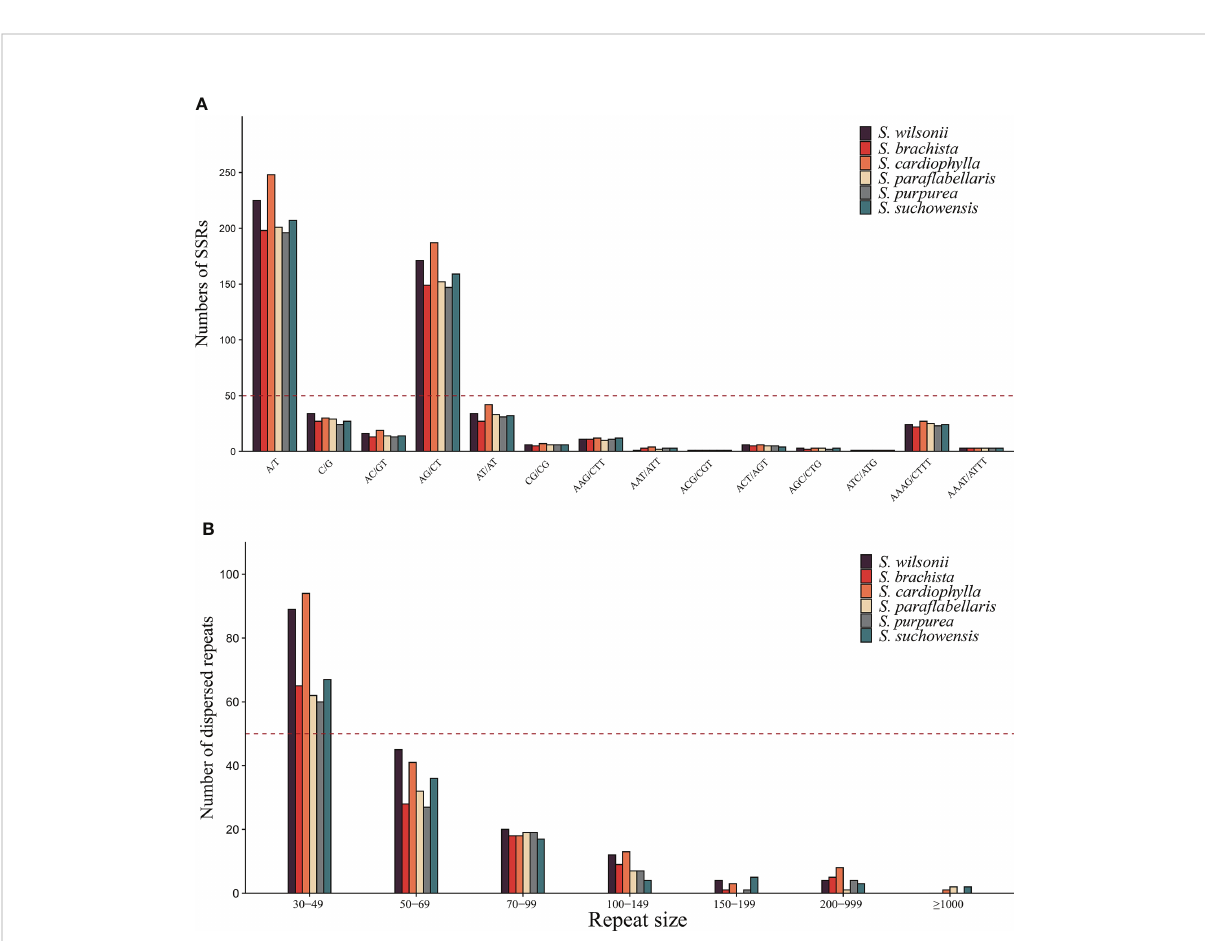
FIGURE 2 Repeat sequences of the genus Salix. (A) Identi fi cation frequencies of SSRs with different repeat types in the genus Salix . (B) The number of dispersed repeats of different lengths in the genus. Salix